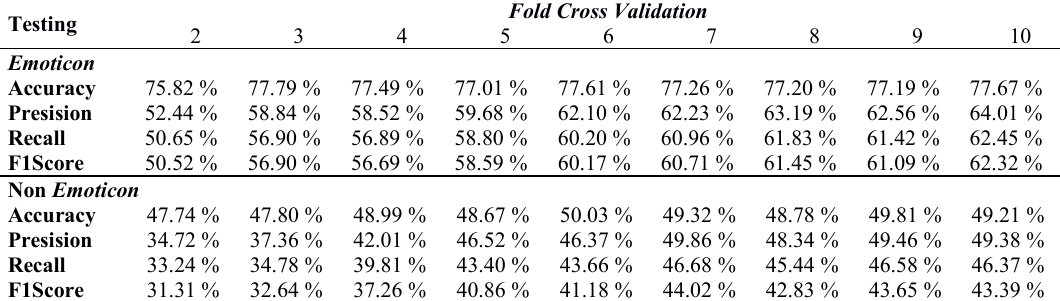
TABLE 5 T HE VALUE OF THE QUALITY OF SENTIMENT ANALYSIS USING THE SVM METHOD